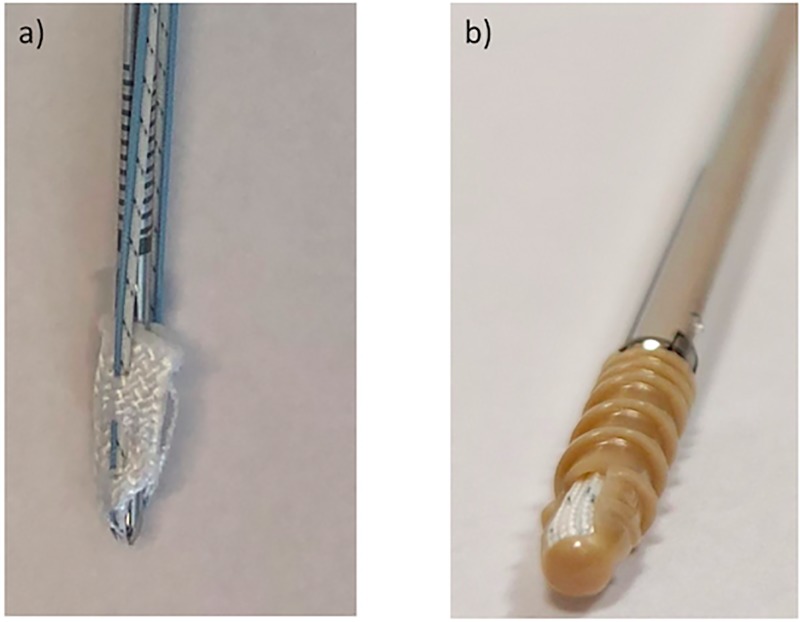
Presentation of the two anchor types used in this study: a) all-suture anchor b) conventional anchor.